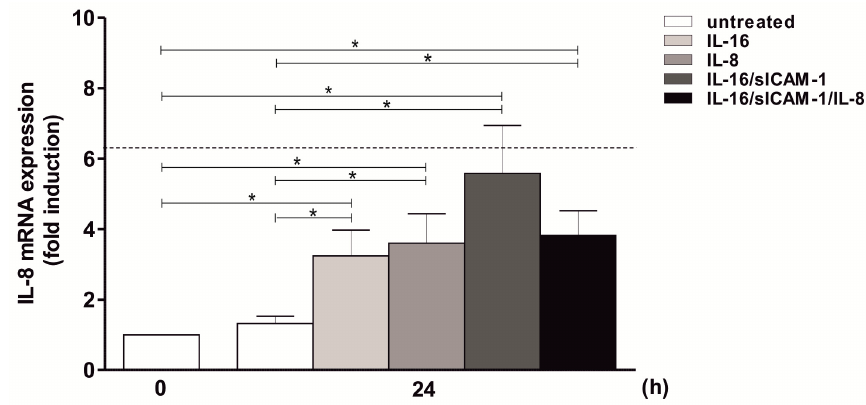
Figure 7. Induction of IL-8 expression by IL-16, sICAM-1, and IL-8 in THP-1 cells. 2 × 10 6 THP-1 cells/well were starved overnight. Afterwards, cells were stimulated with IL-16, IL-8, IL-16 and sICAM-1, or IL-16, sICAM-1, and IL-8 for 24 h (5 ng/mL each). The dashed line indicates IL-8 mRNA expression following TNF stimulation for 2 h as a positive control. IL-8 mRNA expression was determined using qPCR (housekeeping gene: GAPDH); mean ± SD, n = 3 (measured in duplicates). T test, * p ≤ 0.05.